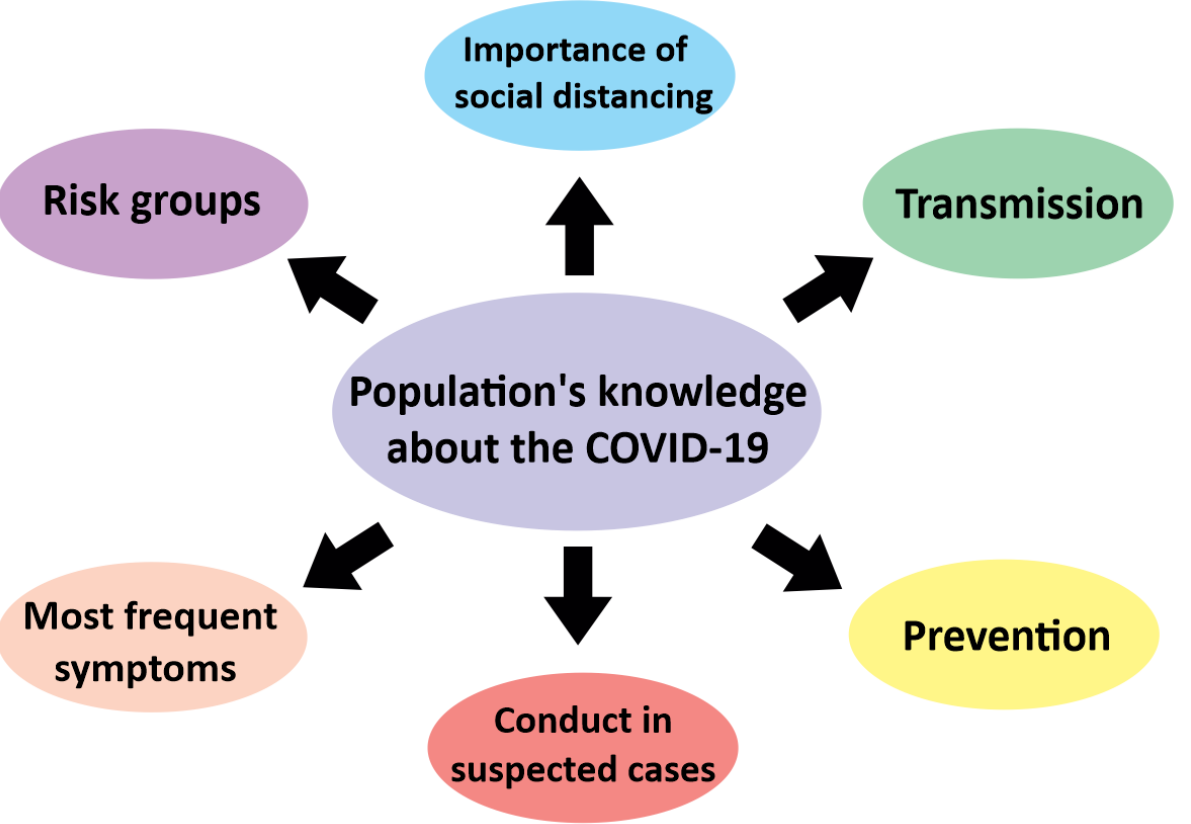
Figure 1. Basic health knowledge investigated in the